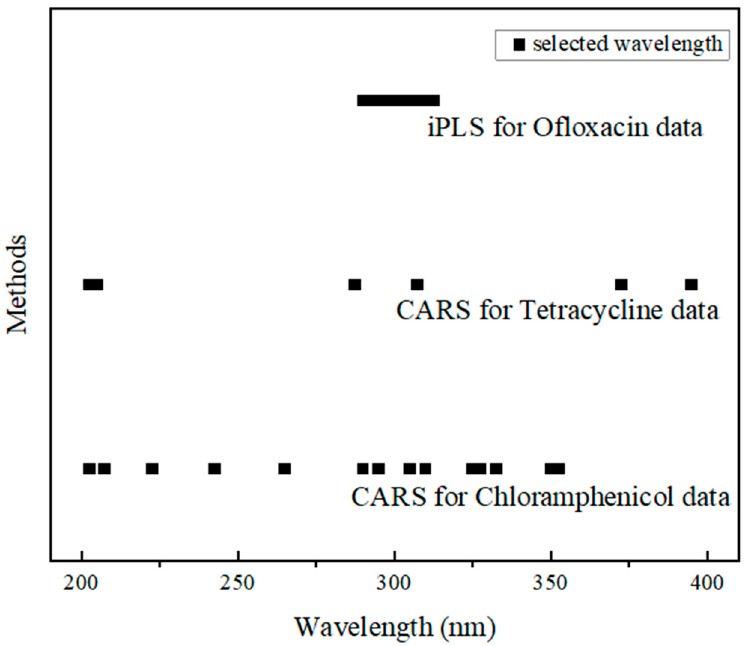
Figure 5. Wavelength selected with iPLS, CARS, and CARS for the three components.